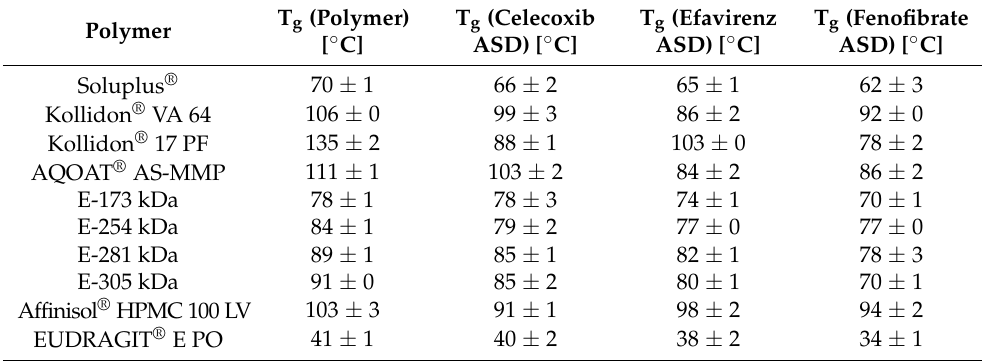
Table 8. Glass transition temperature (T g ) of ASDs incorporating celecoxib, efavirenz or fenofibrate after three months of storage. Each value designates the mean ± S.D. (n = 3). T g Polymer